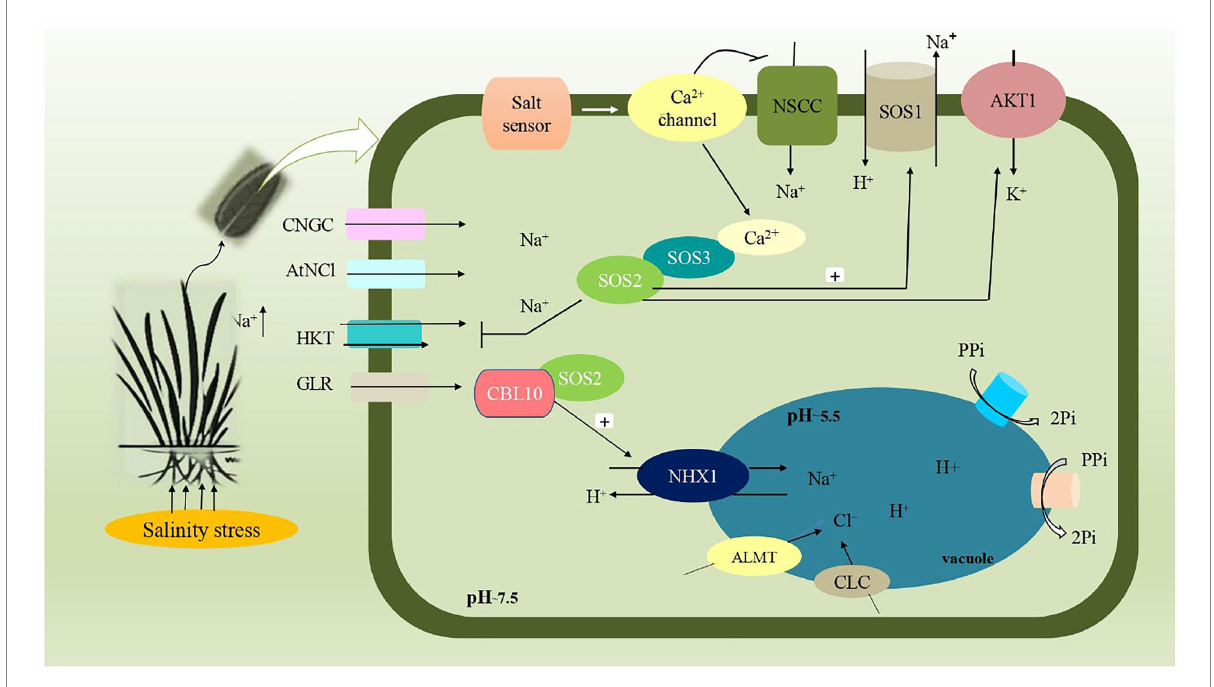
FIGURE 2 Schematic representation involved in salt overlay sensitive pathway (SOS) pathway during salinity stress. Plasma membrane of plant cell and organelle vacuolar membrane are involved in the transportation of Na + ion. Apart from this, influx of Na + into cells are mediated by ion transporters such as Cyclic-nucleotide gated channels (CNGs), Na 2+/ Ca 2+ exchanger (AtNCl), High affinity K + transporters (HKT), Glutamate receptors (GLR), Non-selective cation channels (NSCC). SOS1 (Na + /H + antiporter), SOS2 (Serine/threonine protein kinase) and SOS3 (Calcium bindingprotein) are three genes commonly involved in this pathway that regulates the cytosolic concentration of Na + ion, by subsequent extrusion and compartmentation into vacuoles. Calcineurin B-like (CBL10) along with SOS2 protein mediates the sequestration of Na + ions into vacuole, through vacuolar membrane Na + /H + antiporter (NHX1), thereby maintaining ion homeostasis. Aluminum activated malate transporter (ALMT), Cation/chloride transporter (CLC) mediates the entry of Cl − ion into vacuole. Electrochemical potential is maintained by vacuolar H + - pyrophosphatase (AVP1) and H + -ATPase